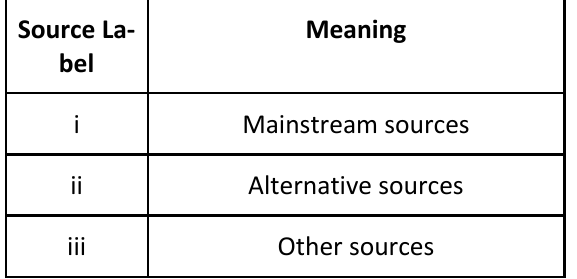
Table 4. Labels used to classify the source type of the collected